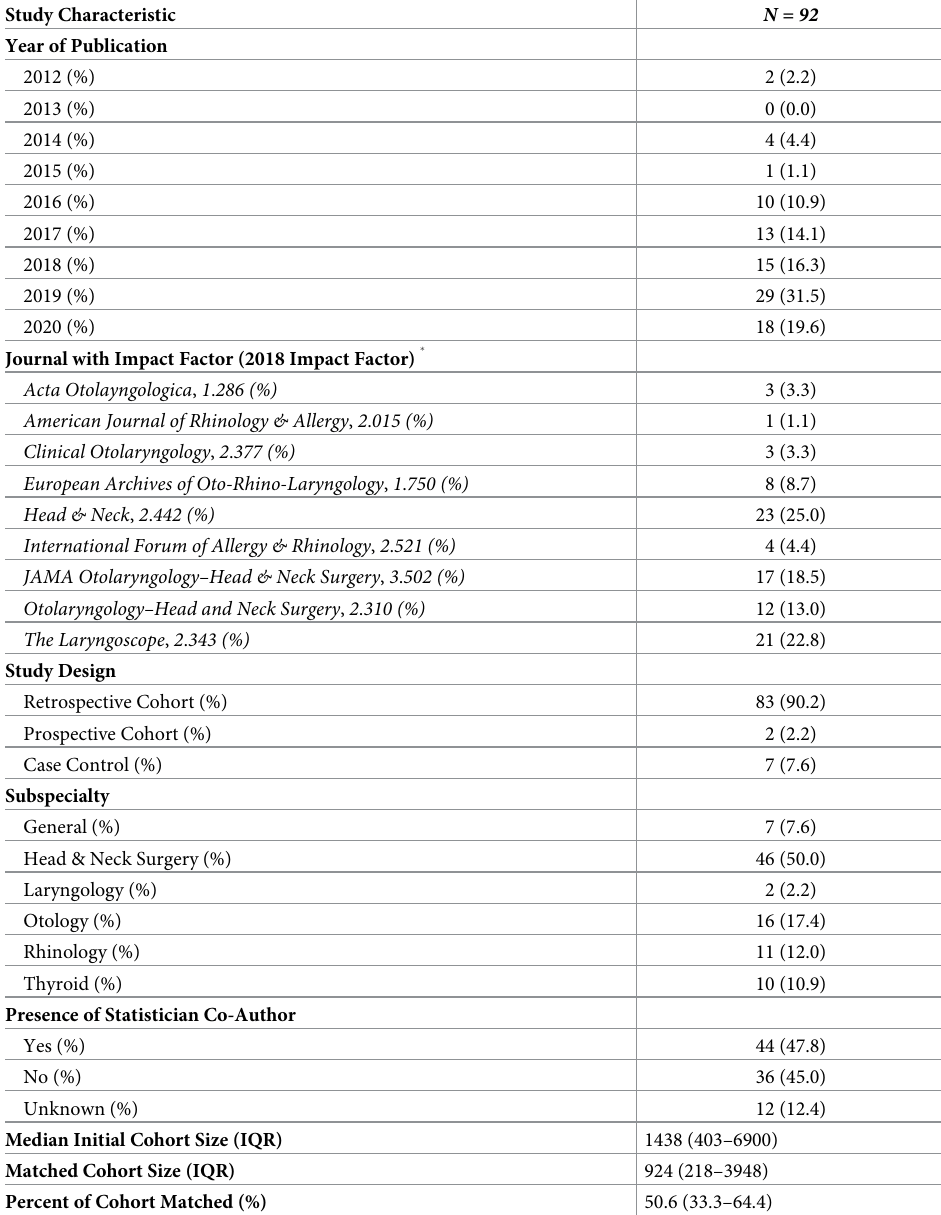
Table 2. Characteristics of included